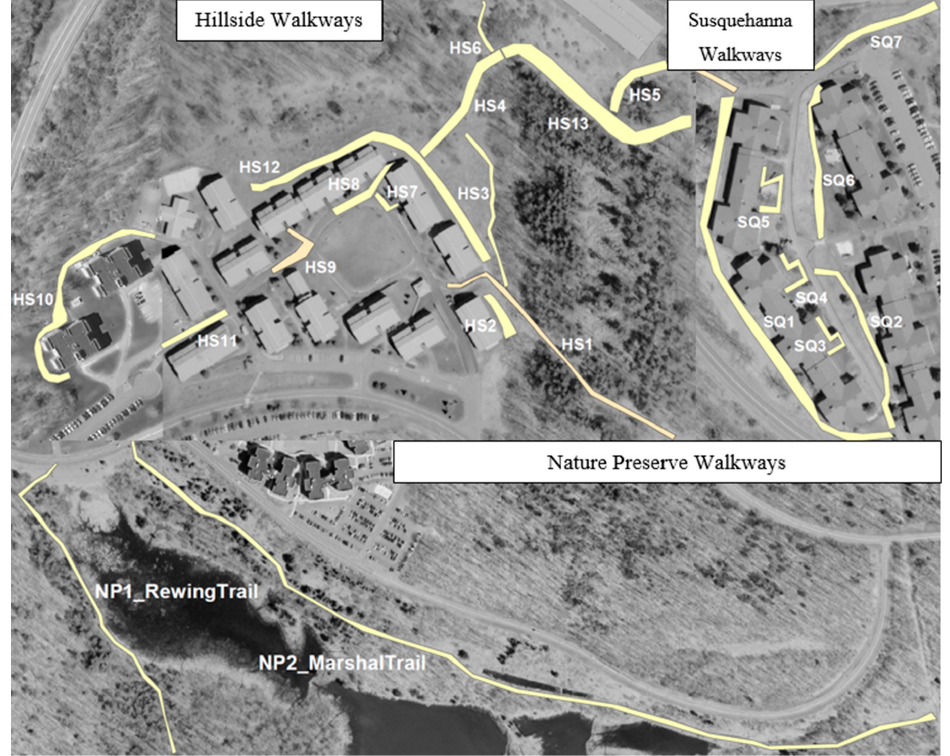
Figure 1. Twenty-two observed campus walkways, including two living areas (Hillside and Susquehanna) and the University Nature Preserve.